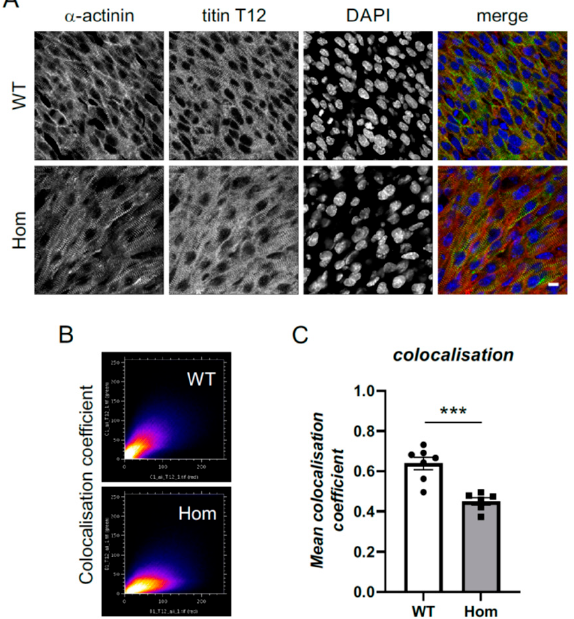
Figure 3. Localisation of alpha-actinin in sarcomeric structures in E15.5 hearts. ( A ) Ventricular wholemount staining for alpha-actinin (first column), titin Z-disk epitope T12 (second column), nuclei visualised by DAPI (third column). Last column shows merged images: alpha-actinin in green, titin T12 in red and DAPI in blue. Scale bar represents 10 microns. Both WT (first row) and Hom animals (second row) show sarcomeric alpha-actinin staining. ( B ) Colocalisation coefficient plots for alpha-actinin and titin T12 for the images in A (see Material and Methods). ( C ) Reduced colocalisation of alpha-actinin and titin T12 in Hom E15.5 hearts (nested ANOVA, *** p < 0.001). Each data point represents the average colocalisation coefficient for one heart, with a total of 43 images from 7 WT hearts and 25 images from 6 Hom hearts analysed.